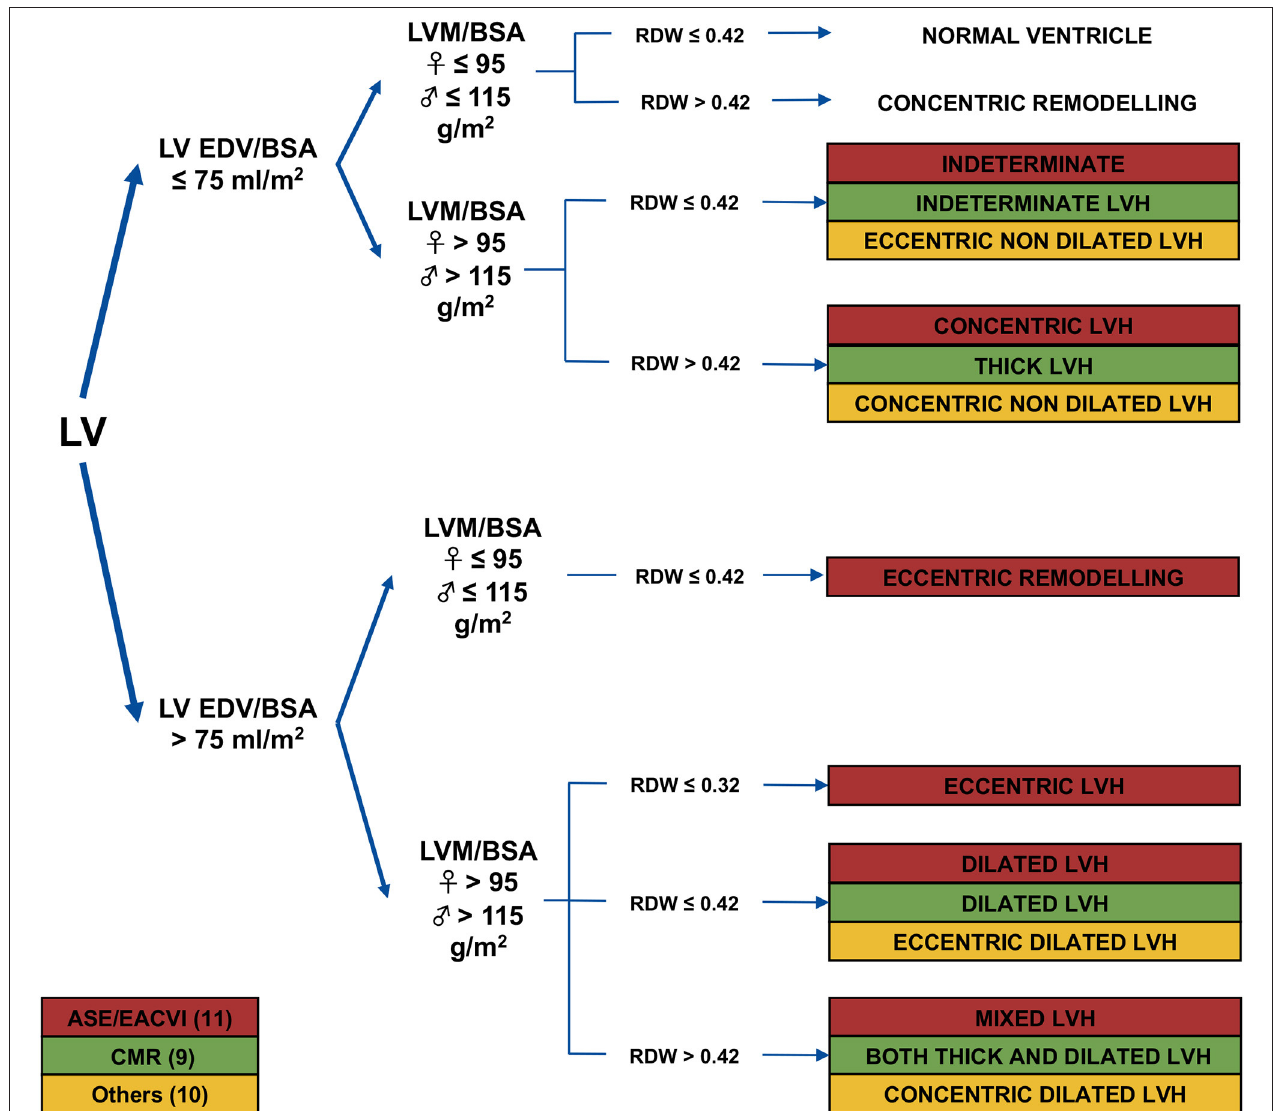
FIGURE 1 | Schematic description of the 4-group left ventricular hypertrophy classification. The different terminology used in the literature and the normal range of parameters under consideration are highlighted. LV, left ventricular; EDV, end-diastolic volume; BSA, body surface area; LVH, left ventricular hypertrophy; RWT, relative wall thickness; ESC, European association of cardiology; CMR, Cardiac magnetic Resonance. Adapted from